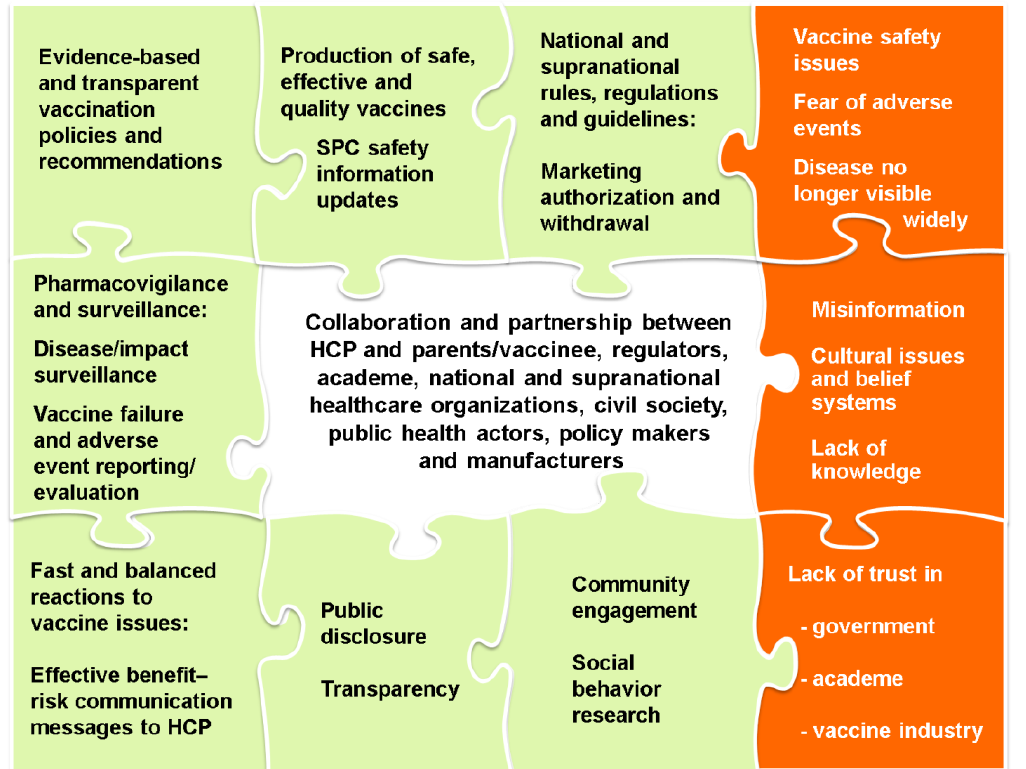
Figure 1. Factors that promote (outer green boxes) or undermine (outer orange boxes) vaccine confidence and collaborations (central box) associated with improved public confidence in